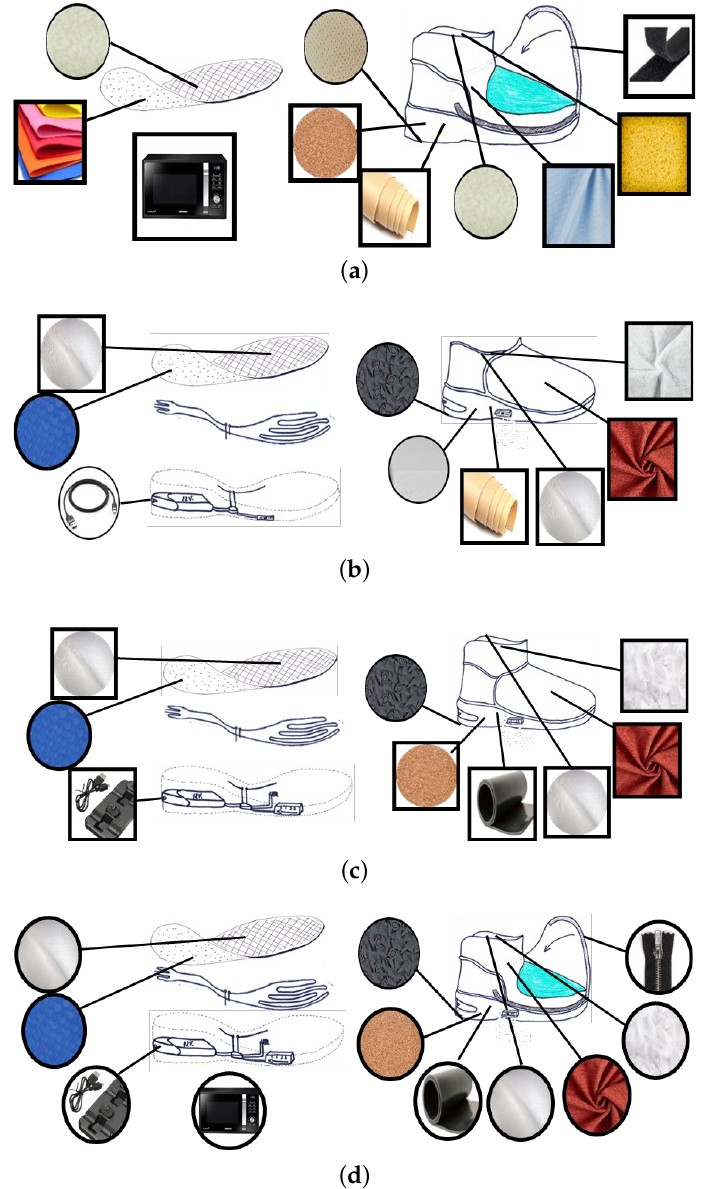
Figure 3. Graphical representation of concepts (cont.): ( a ) Vintage Slipper ; ( b ) Sprint Slipper ; ( c ) Star Slipper ; ( d ) Diamond Slipper